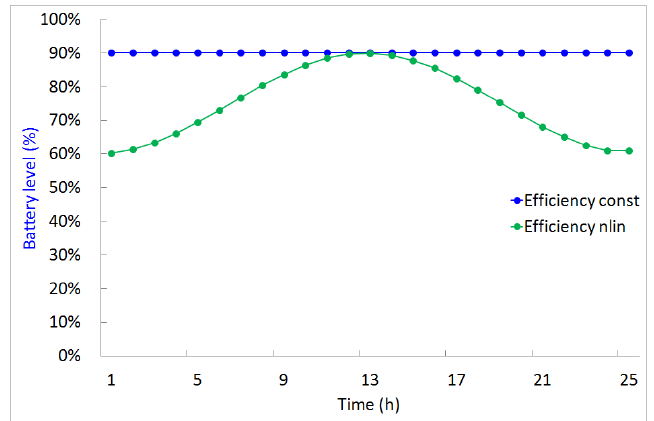
Figure 1. 24 h efficiency changeover: blue line: constant; green line: nonlinear effect caused by temperature drop.